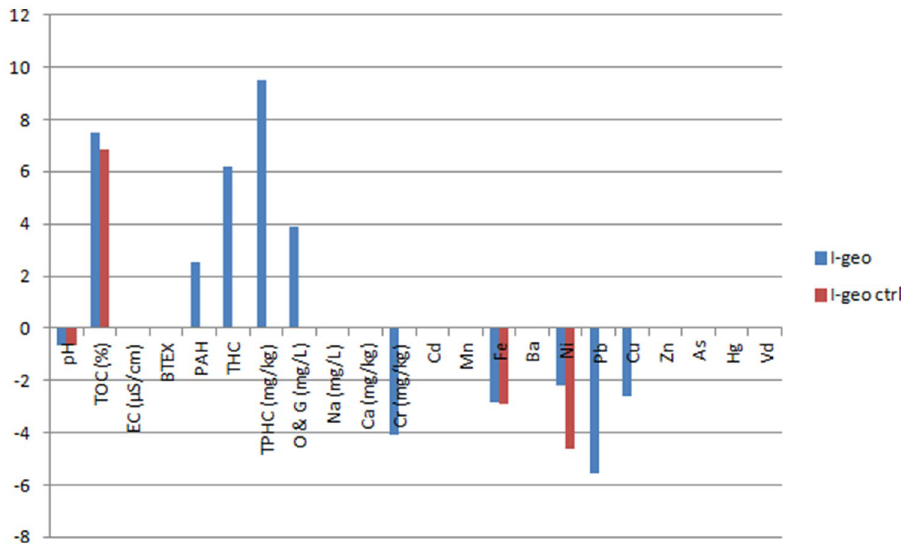
Fig.3 Geo-accumulation Index of the soil samples